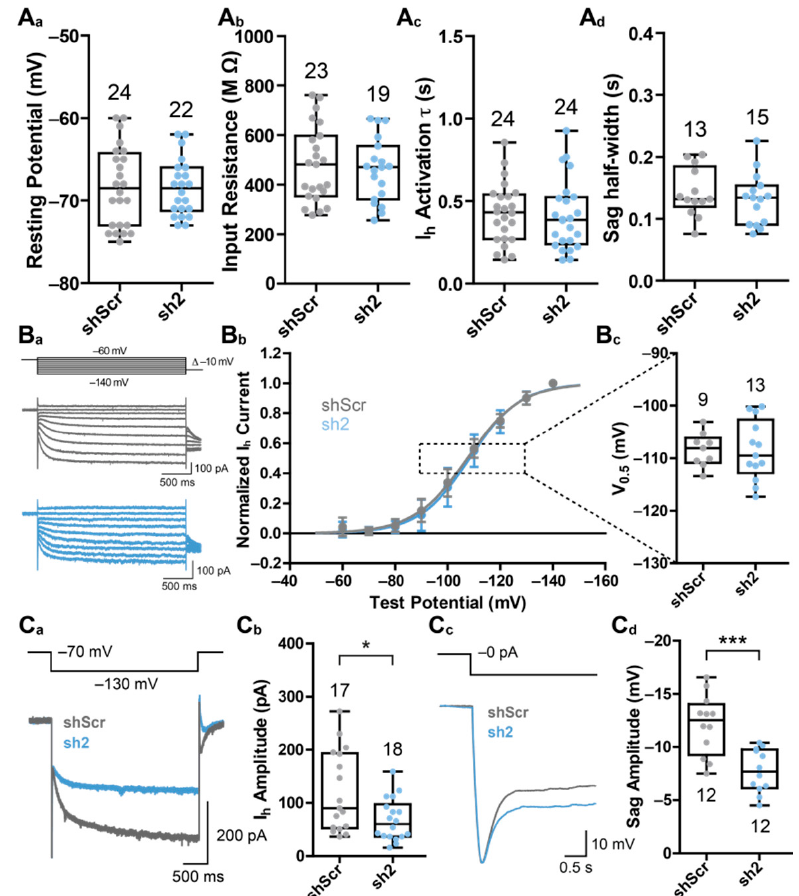
Figure 2. Electrophysiological effects of HCN2 knock-down in PHNs. Results of whole-cell patch-clamp recordings of rAAV9-transduced and eGFP-positive PHNs. ( A ) Effects of HCN2 knock-down on ( A a ) resting membrane potential, ( A b ) input resistance, ( A c ) I h -current activation time constant τ , and ( A d ) Sag-potential half-width. Resting membrane potentials were measured approximately 30 s after establishing the whole-cell configuration. Input resistances were measured with three 10 mV hyperpolarizing voltage pulses. Activation time constants were calculated by fitting the current response of a hyperpolarizing pulse (from − 70 mV to − 130 mV) to a mono-exponential function. Sag potentials were evoked by current pulses hyperpolarizing the membrane potential to − 130 mV. ( B ) Effects of HCN2 knock-down on I h -current activation potentials. ( B a ) Representative voltage stimulation protocols and corresponding current traces of whole-cell patch-clamp recordings derived from PHNs expressing shScr (gray) or sh2 (blue). ( B b ) Current–voltage relationships of shScr- or sh2-expressing PHNs. Currents were calculated from the difference of the instantaneous current and the steady-state current. The continuous lines represent fitted Boltzmann functions of the recorded currents. ( B c ) Half-maximal activation voltages of shScr- or sh2-expressing PHNs calculated from the fitted Boltzmann functions of whole-cell currents. ( C ) Influence of HCN2 knock-down on I h -current amplitude and Sag-potential amplitude. ( C a ) Representative voltage stimulation protocol and corresponding current traces of PHNs expressing shScr (gray) or sh2 (blue). ( C b ) I h -currents were activated by a hyperpolarizing pulse (from − 70 mV to − 130 mV) and calculated from the difference of the instantaneous current and the steady-state current. ( C c ) Representative current stimulation protocol and corresponding voltage traces of PHNs expressing shScr (gray) or sh2 (blue). ( C d ) Sag potentials were evoked by current pulses hyperpolarizing the membrane potential to − 130 mV. Results are depicted as boxplots. Numbers indicate the number of neurons analyzed by patch-clamp electrophysiology. Statistical significance was assessed using unpaired two-tailed Student’s t -test, * p < 0.05, *** p < 0.001.